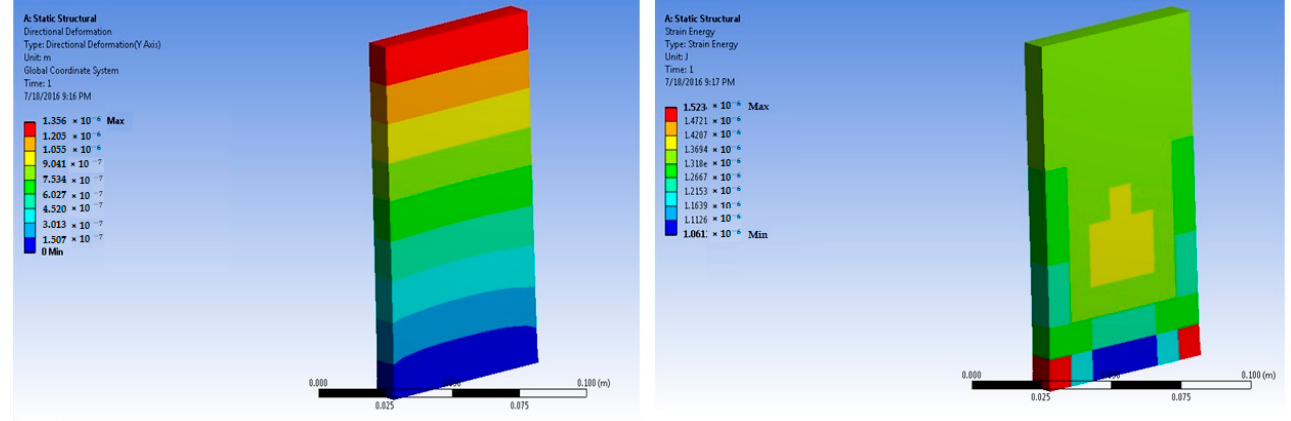
Figure 12. Plain concrete slab at 150 × 10 5 N force (deformation and strain energy). The predicted value for maximum stress at 150 × 10 5 N force was 2.1 × 10 5 Pa. The maximum strain was predicted as 1.25 × 10 − 5 m/m.